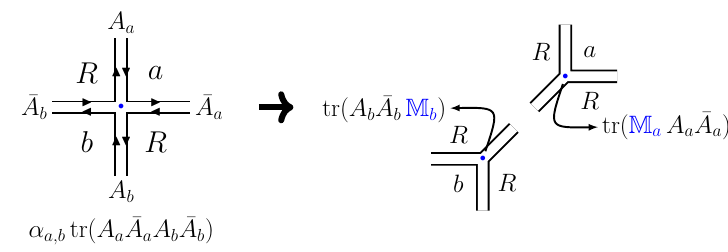
Figure 27 . Splitting a BPS vertex by introducing hermitian matrices M = (cid:11) a;b . M a M b h i